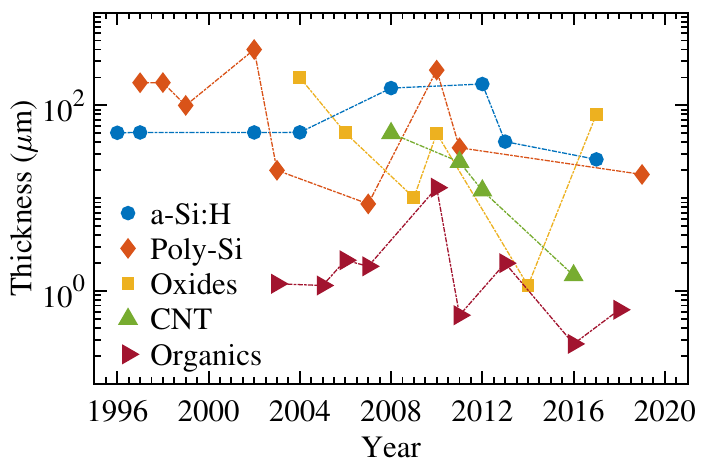
Figure 13. The comparison of thickness over a-Si:H, poly-Si, oxides, CNTs, and organic semiconduct- ing